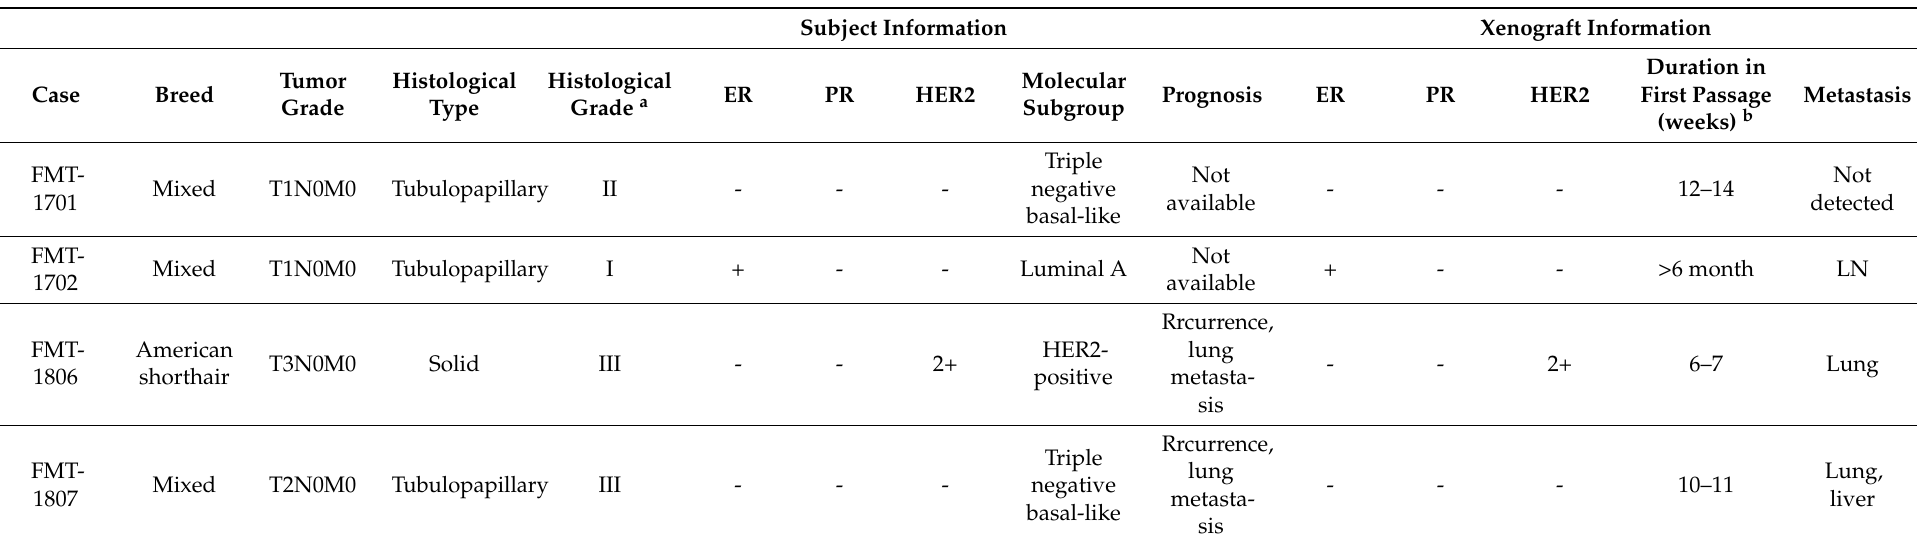
Table 3. Data for each tumor case and corresponding FMT-PDX